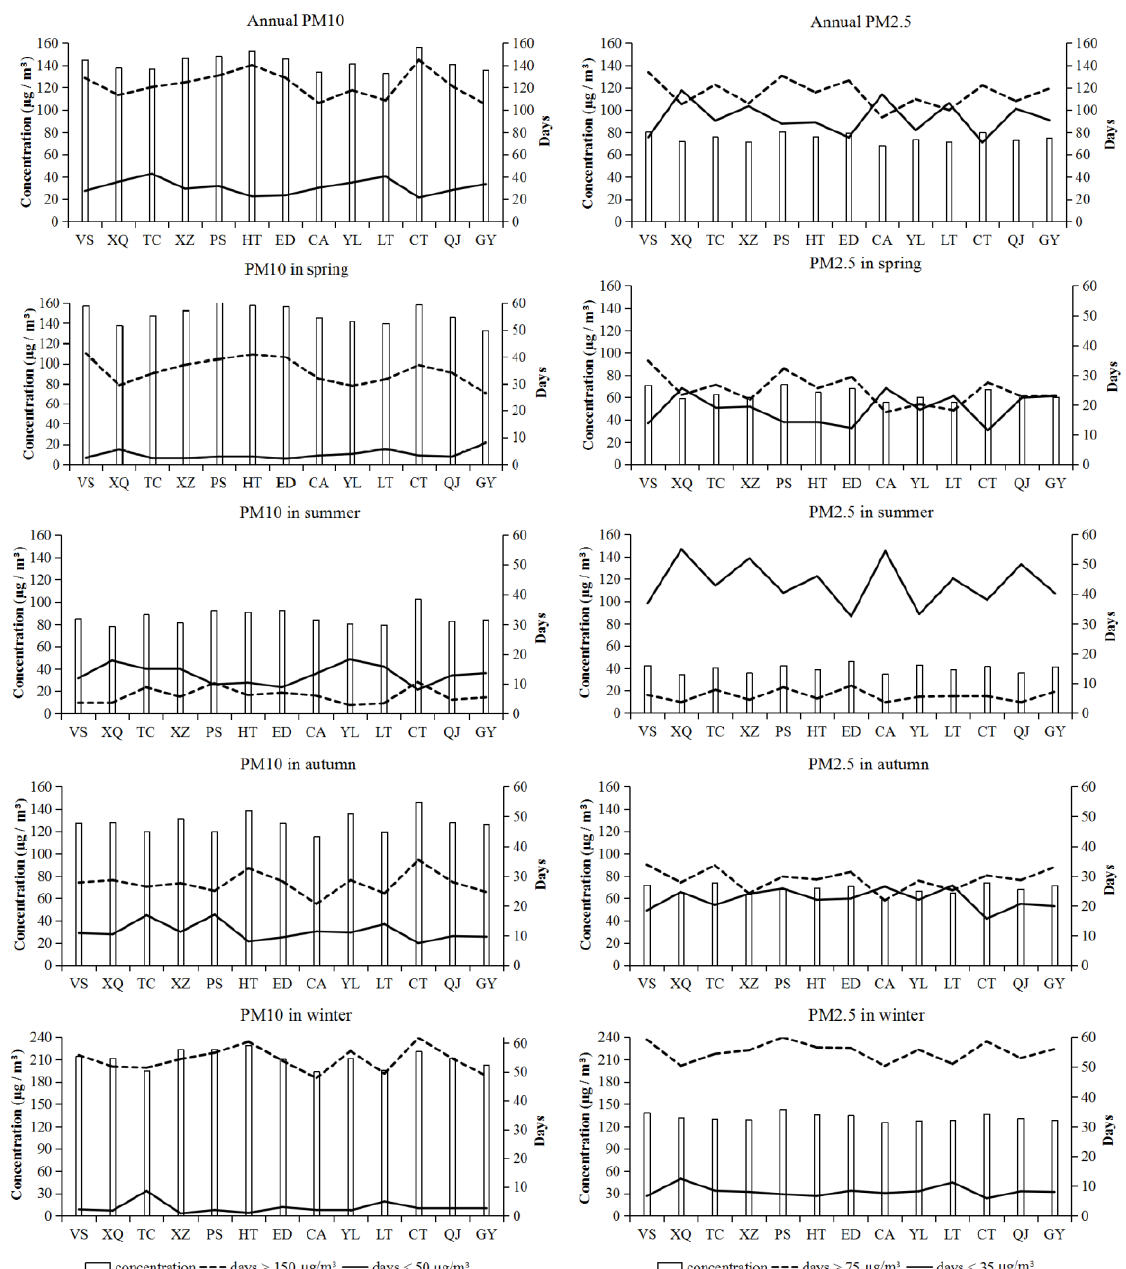
Figure 3. Annual and seasonal concentrations of PM10 and PM2.5 and the days that the concentrations lower than Grade 1 and higher than Grade 3 at different monitoring stations in Xi ’ an.